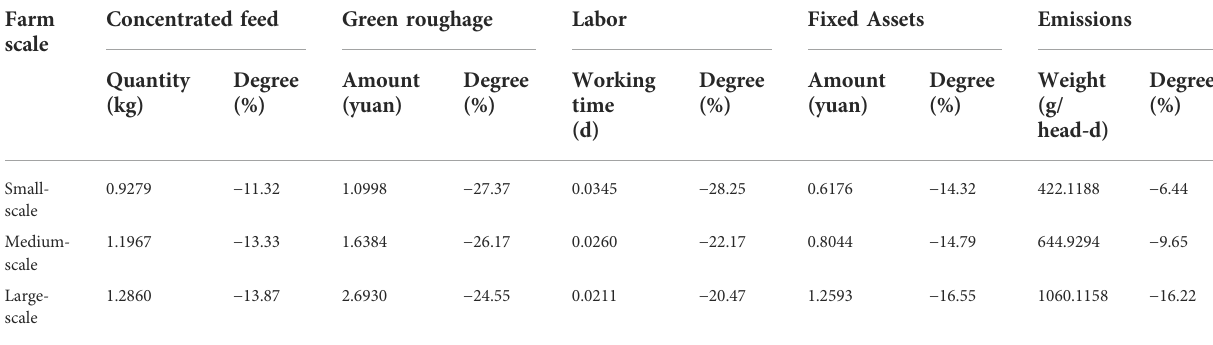
TABLE 6 Quantity and degree of improvement of input factors and pollutant emission of dairy farms of different sizes.